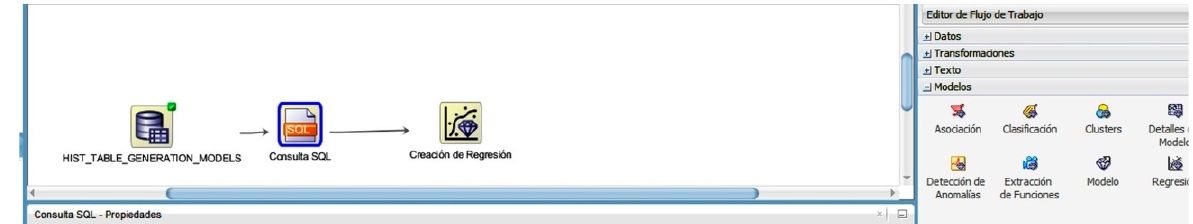
Figure 6. Tool for the design and development of the predictive models.